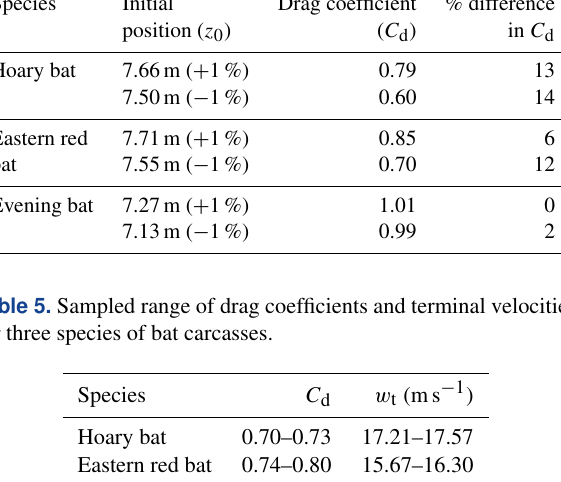
Table 4. Drag coefficient sensitivity with respect to initial position.